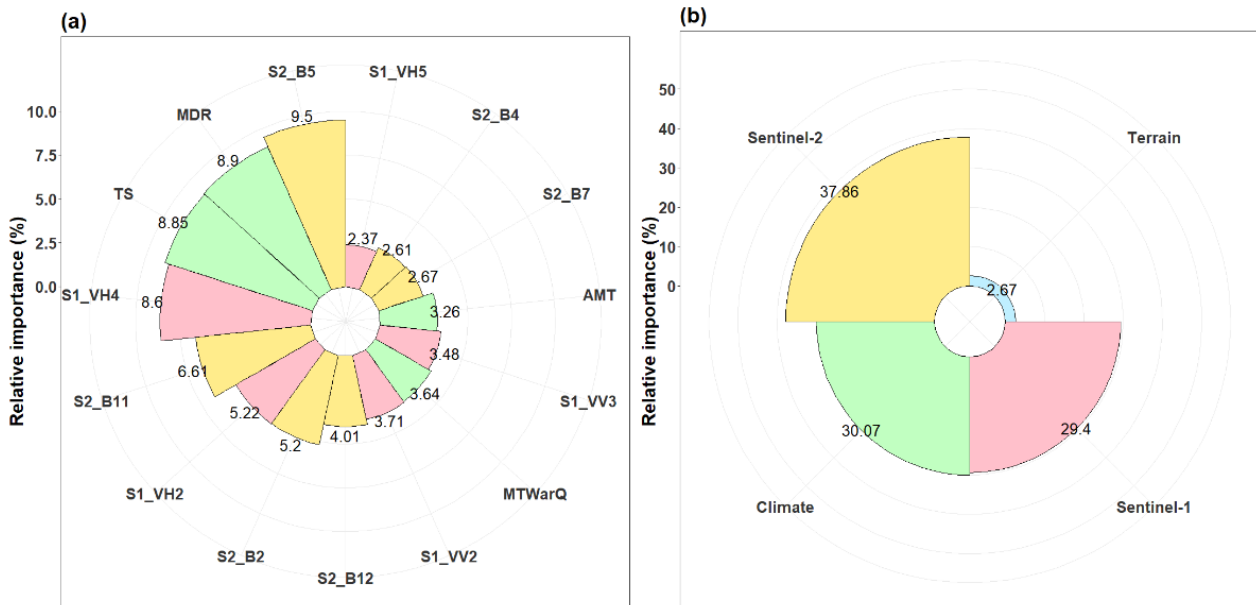
Figure 6. Relative variable importance estimation for the best model. ( a ) The relative importance of the top 15 most important variables, and ( b ) relative importance of different environmental variables groups.